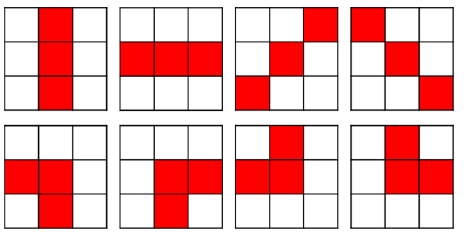
Figure 7. The 3 × 3 block patterns for touch point detection.